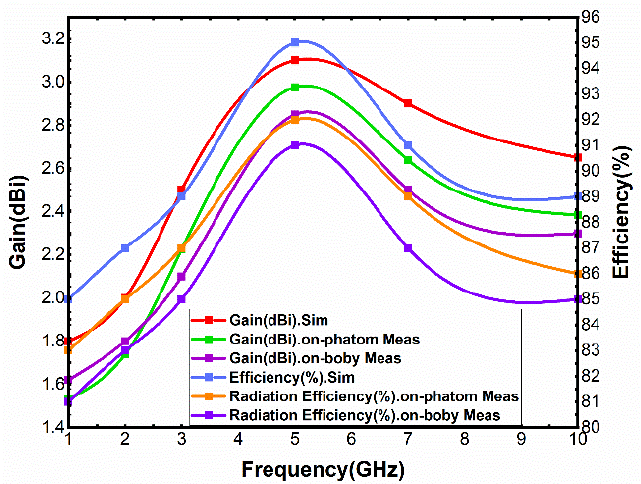
Figure 13. Simulated and measured gain and efficiency conditions.